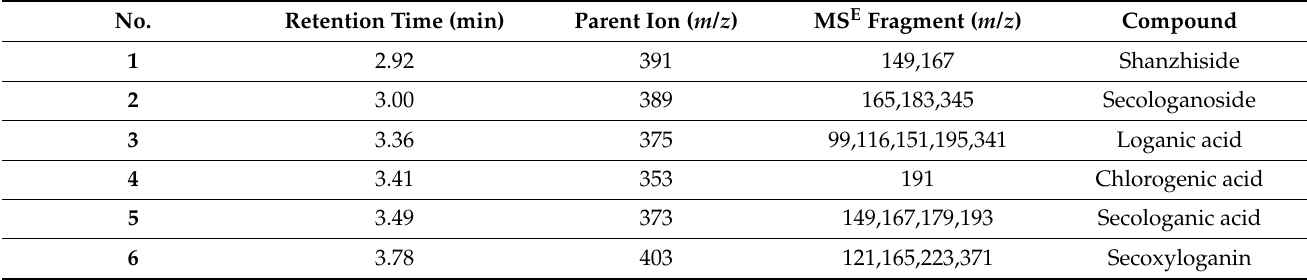
Figure 1. UPLC Q–TOF/MS E chromatography in negative ion mode of Lonicera japonica . Table 2. Identification of main compounds of Lonicera japonica